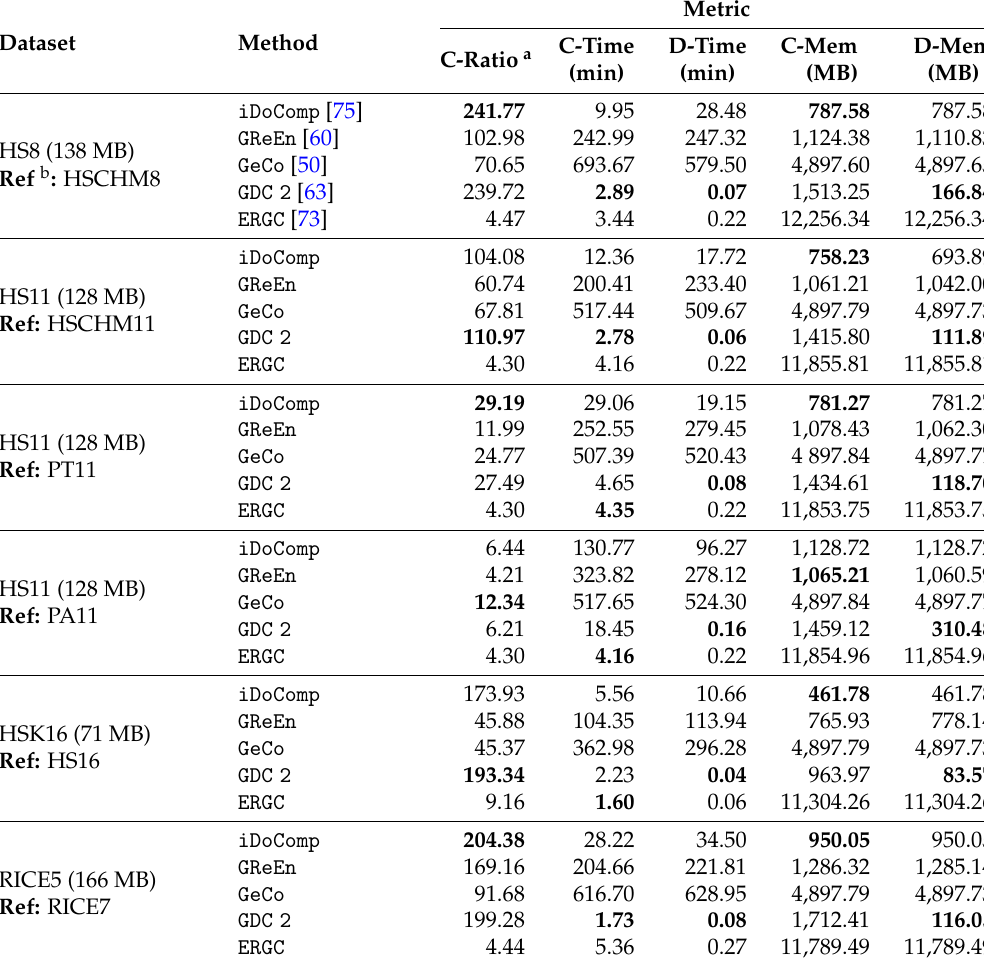
Table 6. Compression results of reference-based